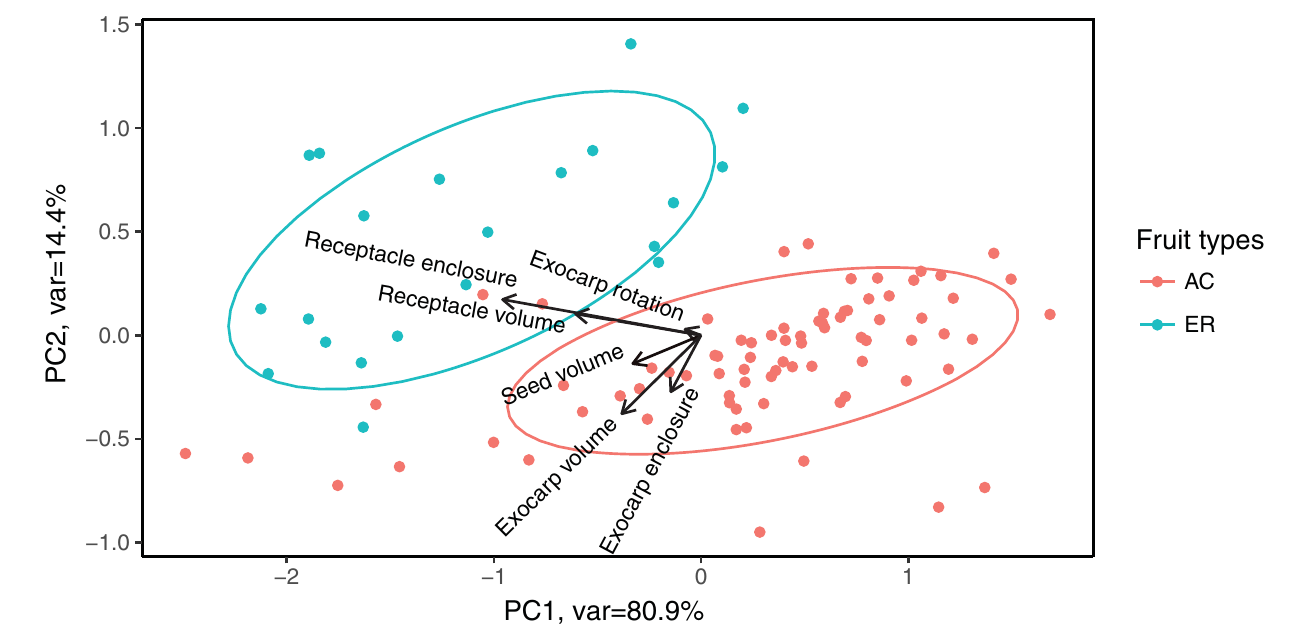
Fig 5. PCA of 98 species geometric mean of all dimensions of the two fruit types. AC and ER stand for acorn and enclosed fruit type respectively. Each dot represents a single species. The ellipses represent 68% confidence interval. The arrows represented the contributions from each variable.